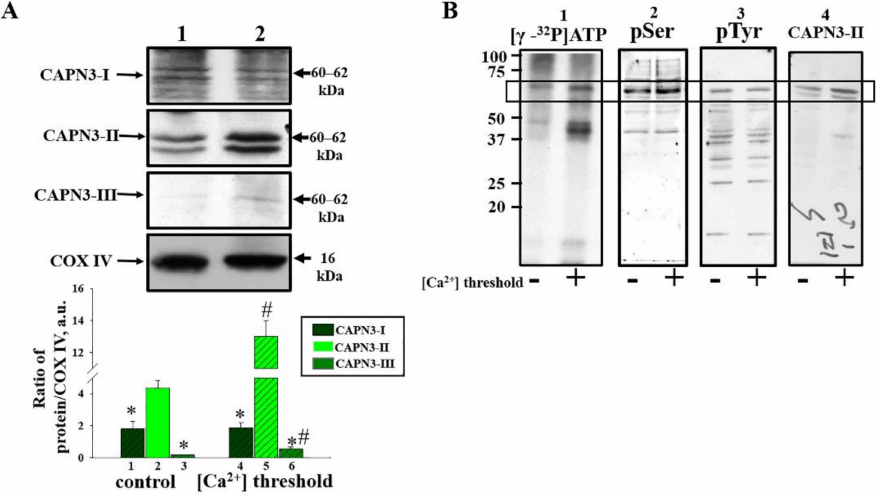
Figure 4. Determination of changes in the level of Calpain 3 under mPTP conditions (threshold [Ca 2+ ]). ( A ): Alterations in the levels of 3 different catalytic domains of CAPN3 ( I , II and III , respectively). The upper parts represent Western blots stained with the corresponding antibodies. The lower parts present the quantitation of immunostaining using computer-assisted densitometry. The protein band intensity was quantified after normalization to COX IV. ( B ): Detection of possible amino acid residues involved in CAPN3 phosphorylation. 1—The spectrum of mitochondrial phosphoproteins: control conditions (without calcium) and mPTP conditions (threshold [Ca 2+ ]); 2 and 3—Western blot with p-Ser and p-Tyr antibodies, respectively; 4—Western blot with CAPN3-II antibody. 60–62 kDa protein is marked with a rectangle. The values shown are the means ± SD from three independent experiments. * p ≤ 0.05 compared with the corresponding value of Calpain 3 II, (columns 1, 3 vs. column 2 and columns 6 and 4 vs. column 5, respectively), # p ≤ 0.05 compared with the corresponding control without [Ca 2+ ] threshold (columns 4 vs. 1, 5 vs. 2 and 6 vs. 3,